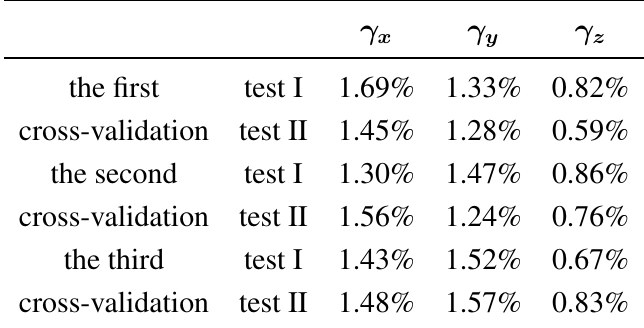
Table 3. Error analysis of decoupling algorithm by (cid:15) -SVRs.